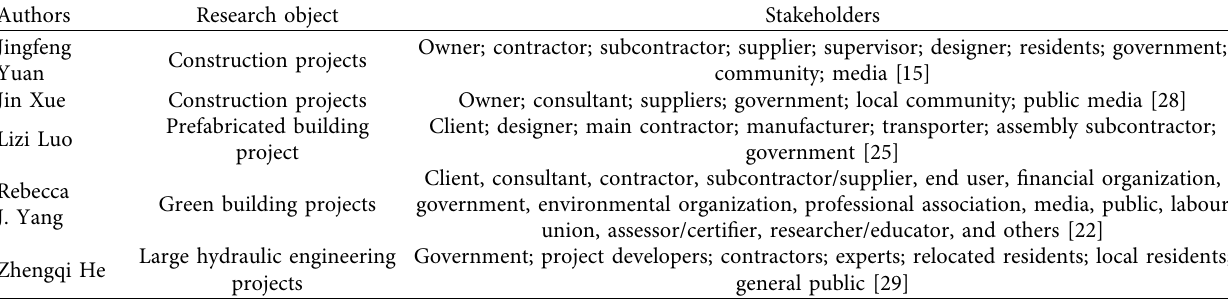
Table 1: Stakeholders in the engineering project.